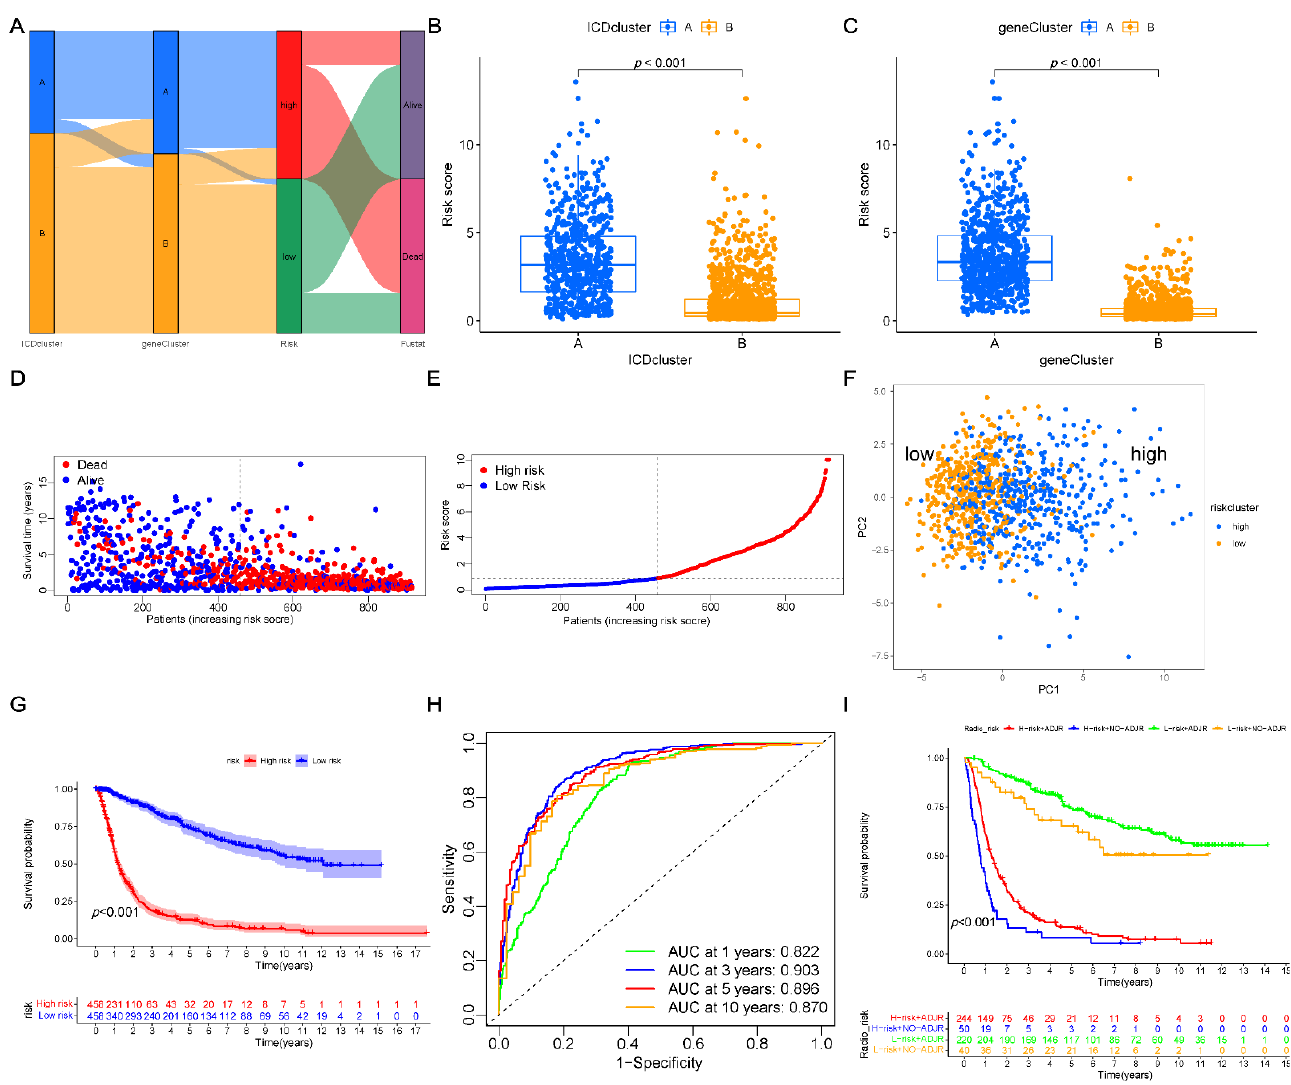
Figure 5. Development of the risk score system using the training set. ( A ) Sankey diagram present- ing the distribution of different subtypes. ( B ) Difference in the risk scores of two ICD-related gene clusters. ( C ) Difference in the risk scores of two DEGs clusters. ( D , E ) Ranked dots and scatter plots, presenting the distribution of risk and survival outcomes of patients. ( F ) PCA analyses, indicating a significant difference between the two risk groups. ( G ) Kaplan–Meier curves for the two risk groups to assess the OS ( p < 0.001). ( H ) ROC curves of the risk score to assess the sensitivity and specificity of 1-, 3-, 5-, and 10-year survival rates. ( I ) Kaplan–Meier curves for four groups combining risk score and adjuvant radiotherapy to assess the OS ( p < 0.001). ICD, immunogenic cell death; DEGs,